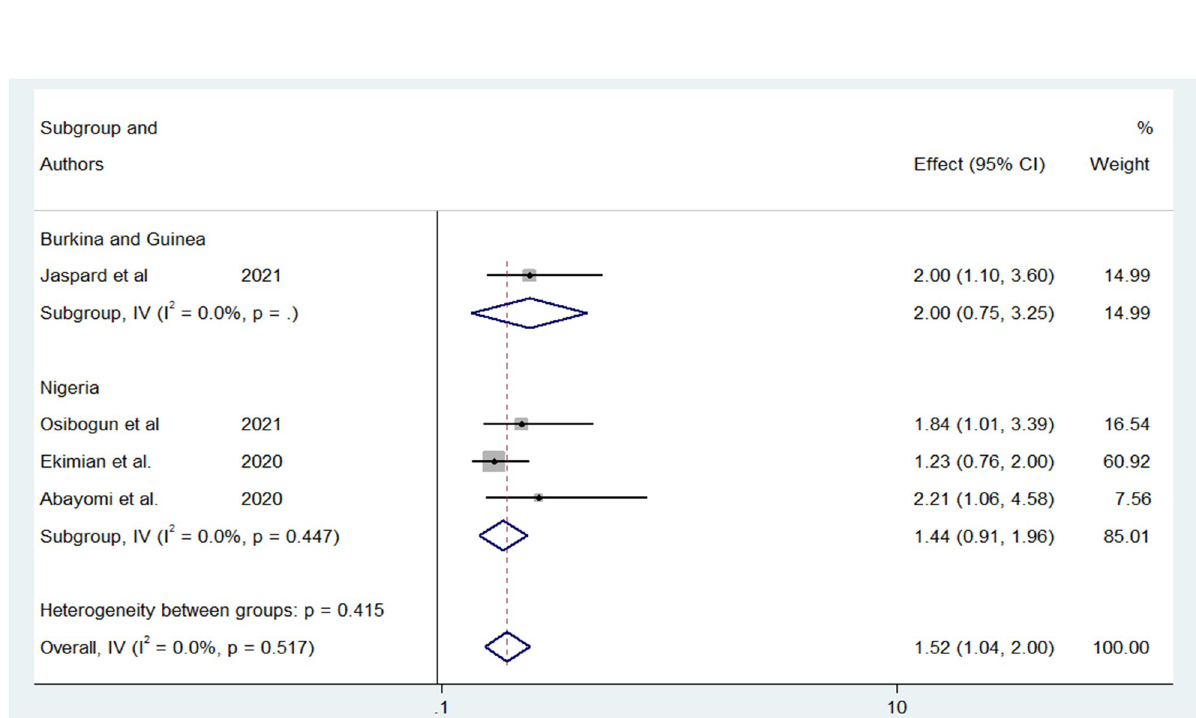
Fig 4. Forest plot showing the estimate for the effects of sex on COVID-19 mortality.